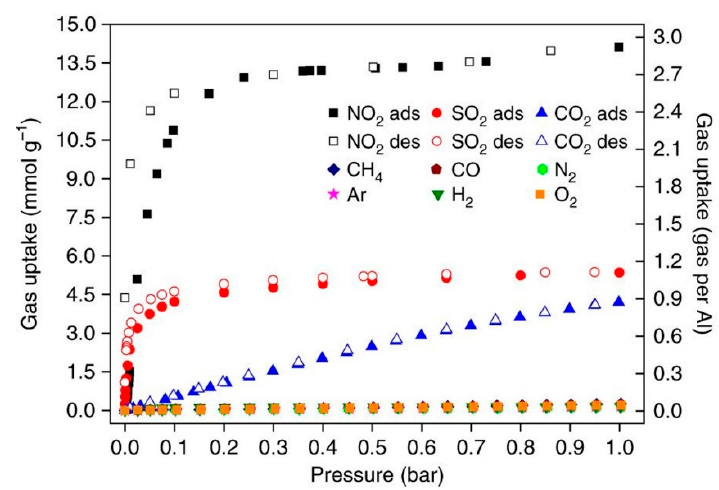
Figure 1. Gas uptake properties of MFM-300 (Al) in various gas environment such as NO 2 , CO 2 , SO 2 , CH 4 , CO, N 2 , H 2 , O 2 , and Ar (open symbol: adsorption, solid symbol: desorption). Reproduced and adapted from Ref. [6]; Copyright (2018), Springer Nature.